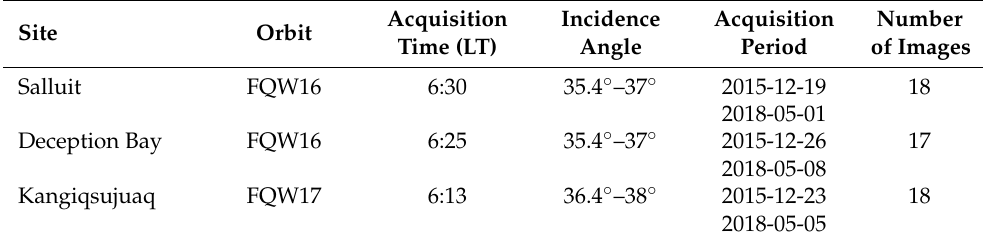
Table 4. RADARSAT-2 acquisition parameters. Local time (LT) is UTC-5